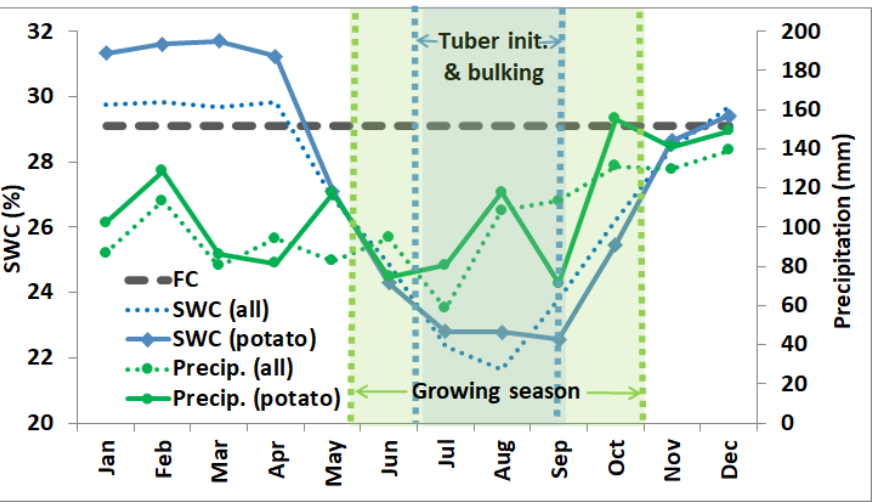
Figure 3. Field capacity (FC) and monthly averages for soil water content (SWC) and precipitation for potato and for all crops for the representative year.